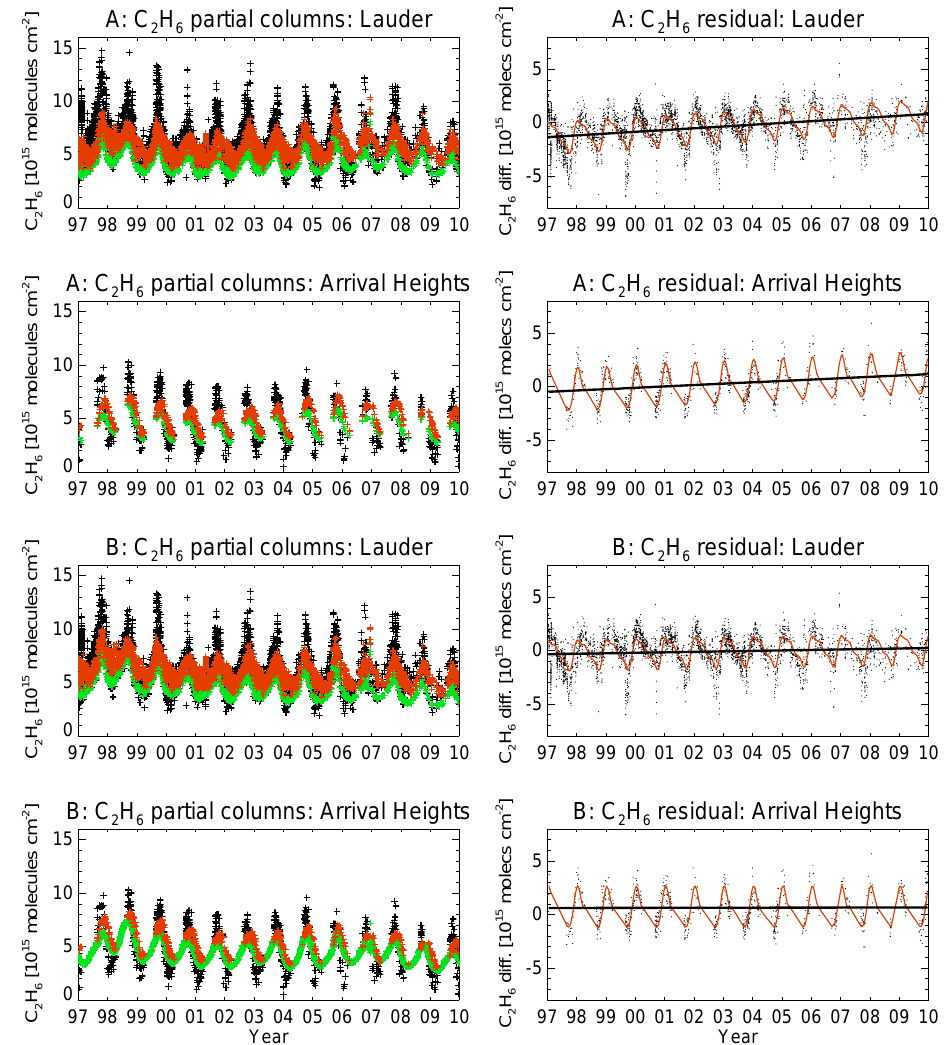
Fig. 4. Left panel: C 2 H 6 partial columns from observed (black), original model (green), and model data convolved with averaging kernels and a priori (red) at Lauder and Arrival Heights. “A” denotes runs with annually periodic anthropogenic emissions and “B” denotes runs with declining anthropogenic emissions in CO and C 2 H 6 . Original model data are also shown at Arrival Heights for the wintertime when no measurements were taken (Simulation B). Right panel: corresponding residuals between observed and convolved model data (modelled- observed) for C 2 H 6 at Lauder and Arrivals Heights from runs A and B. Black symbols denote observed residuals, red lines denote 4th order trigonometric-polynomials and a linear trend regression fitted to the residuals, and black lines are only the linear trends of those regression